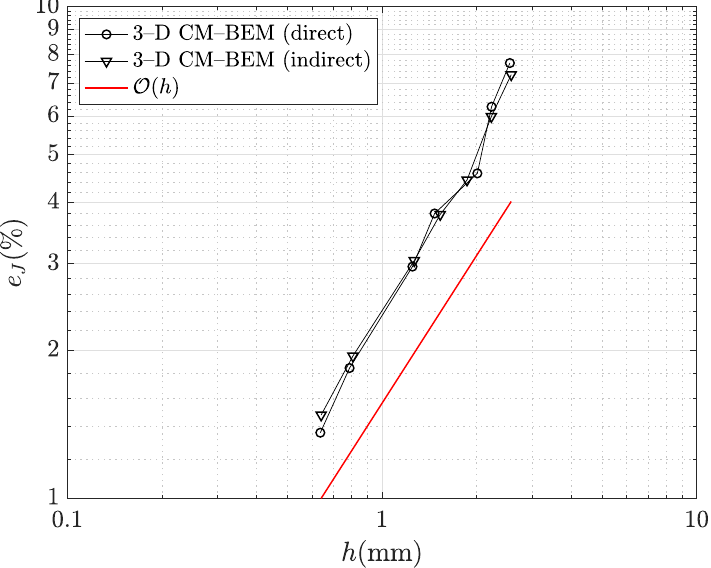
Figure 6. Discrepancy ( L 2 -norm) in Ω between the eddy–current density computed by 2D FEM (third order elements, taken as a reference) and 3D CM–BEM (direct/indirect approaches). The red line expresses theoretical first-order convergence typical of 3D FEM with linear